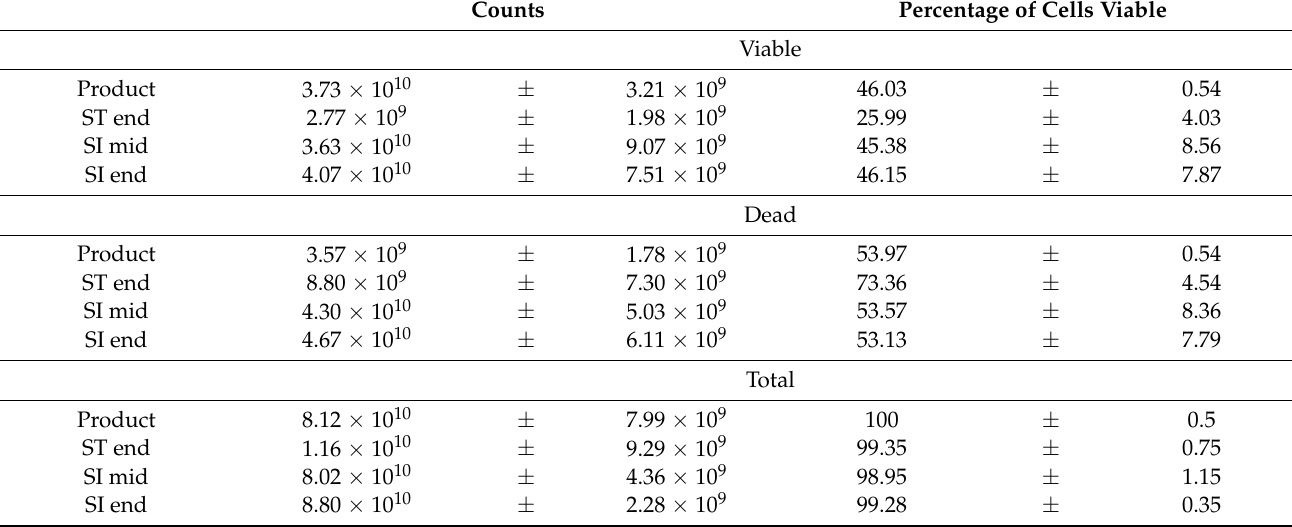
Table 1. Viable, dead and total bacterial cell counts for the product at different stages of the upper gastrointestinal digestion in vitro . Values represent mean ± SD ( n = 3). Product = total count in product at beginning of the experiment; ST = stomach conditions; SI mid = conditions mimicking middle of the small intestine; SI end = conditions mimicking the end of the small